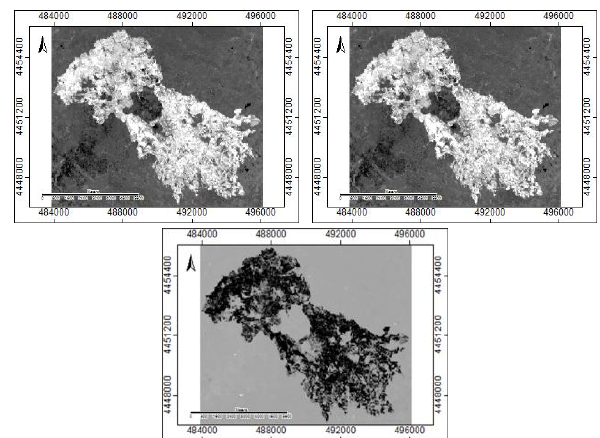
Figure 4. Calculated subtracted indices. RBR (a), dNBR (b), dBAI